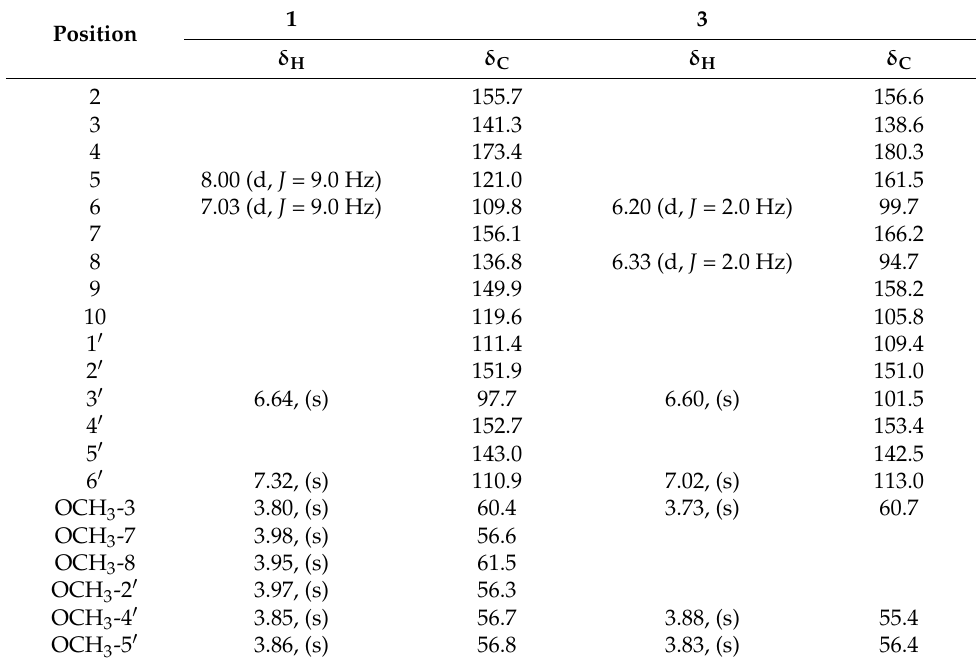
Table 1. 1 H and 13 C NMR data of compounds 1 and 3